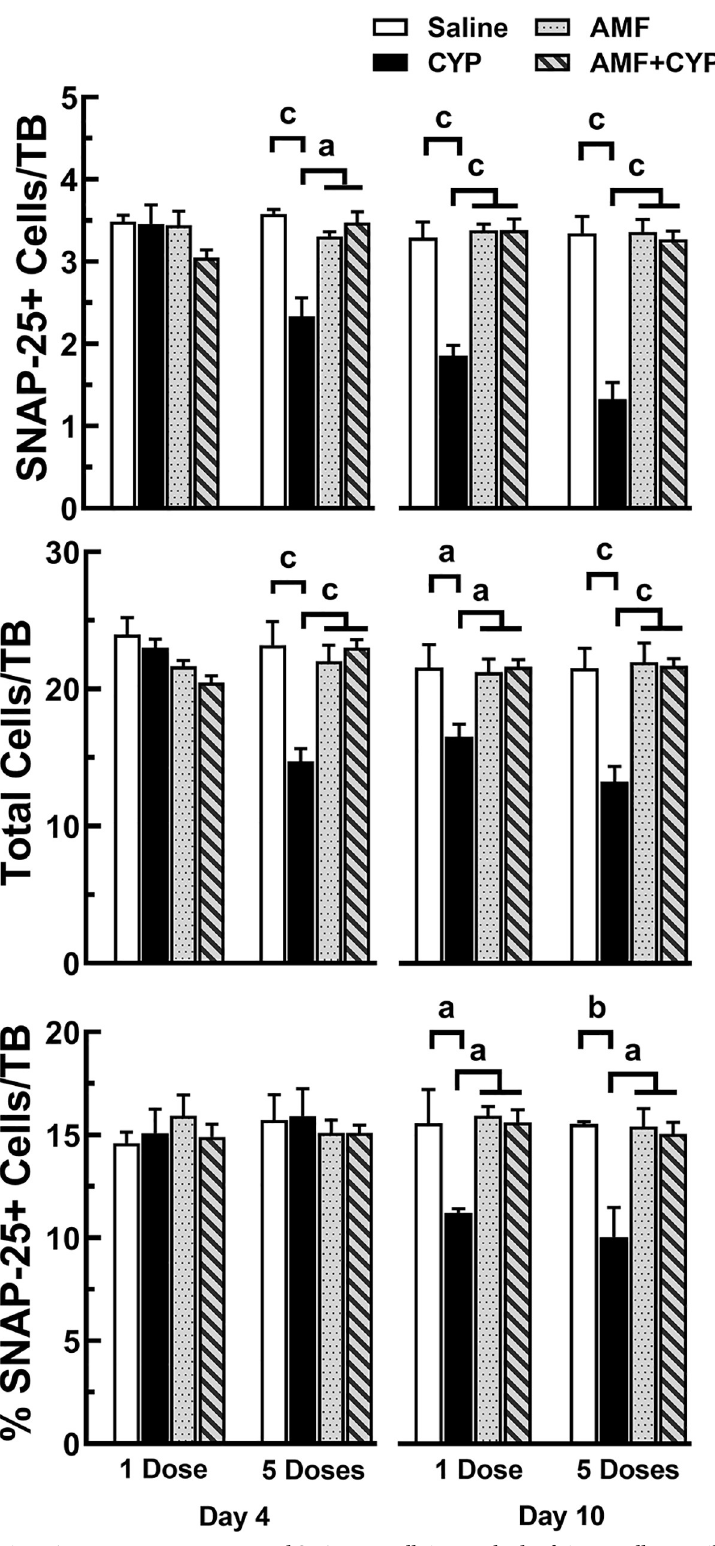
Fig 6. AMF pretreatment protected SNAP-25+ cells in taste buds of circumvallate papillae from CYP. Means + SEM of SNAP-25+ cells (top graph), total cells in taste buds (middle graph), and percent of SNAP-25+ cells/taste bud